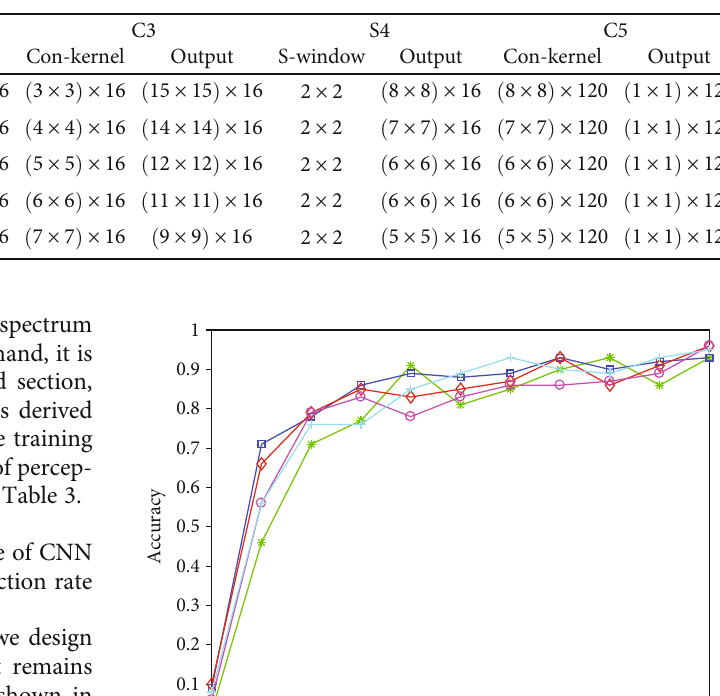
Table 4: Design CNN with 5 di ff erent network structures.